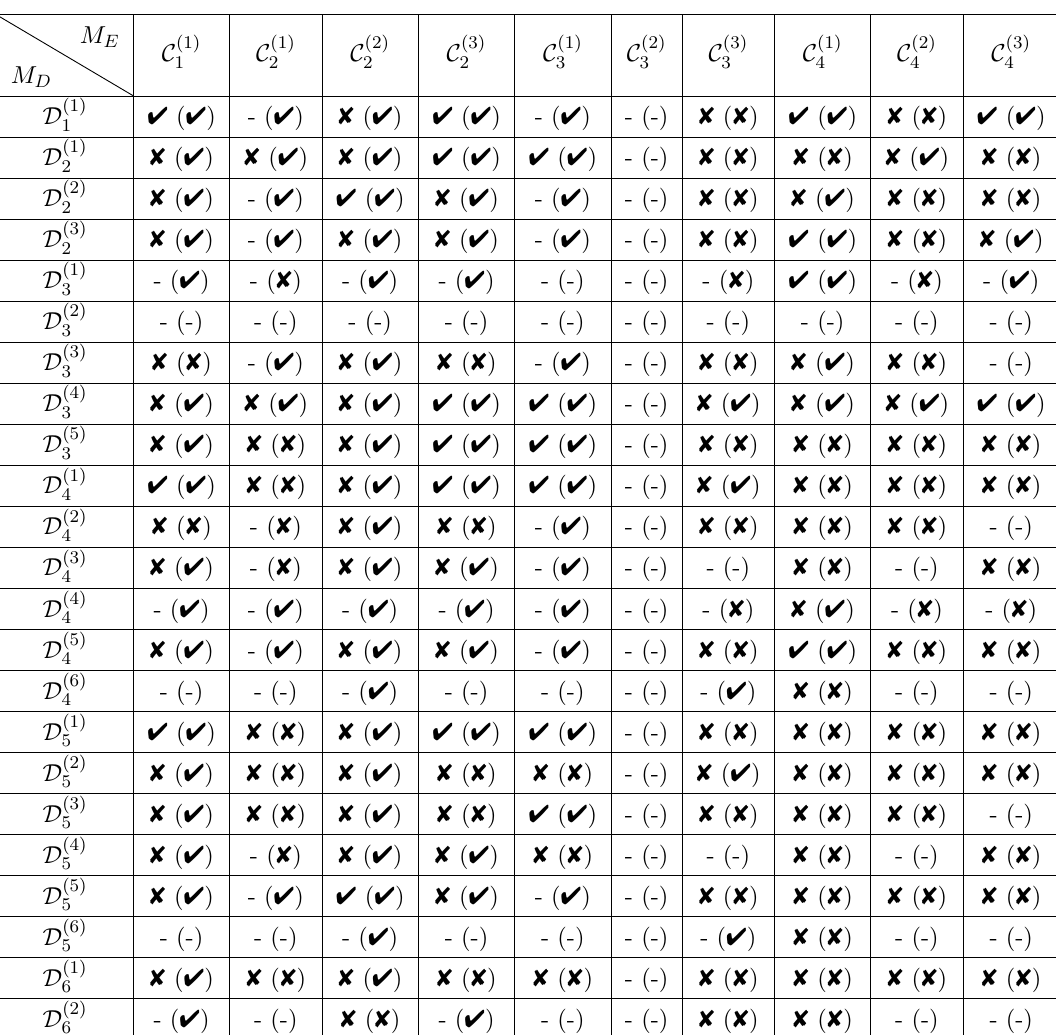
Table 8. Allowed combinations of ( M E , M D ) realised by T 0 modular symmetry with and without gCP for NO neutrino mass spectrum. For all texture pairs the symbol inside (outside) the paren- thesis corresponds to the case when gCP is (is not) imposed. Also, “-” means that a particular configuration cannot be achieved by modular symmetry, while “ 4 ” (“ 8 ” ) identifies those cases which are realised by the modular symmetry and (but) are (are not) phenomenologically